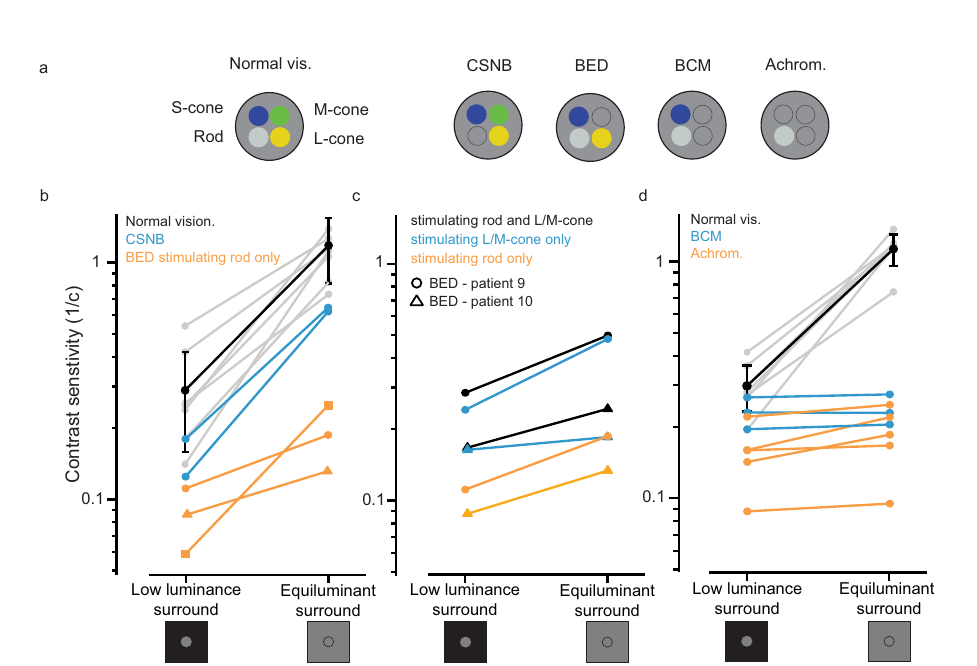
Fig. 1 A lateral adaptive input improves contrast encoding in human subjects. a Schematic of the experimental procedure. A two-alternative forced- choice task was used to measure temporal and spatial contrast sensitivity thresholds. b , c Vision was improved by an equiluminant (27.7 cd/m 2 ) vs low luminance (0.15 cd/m 2 ) surround in normal vision subjects. Temporal contrast sensitivity shown in b ( n = 8 normal vision subjects; 4 Hz p = 0.0018; 7 Hz p = 0.0010; 10 Hz p = 0.0046; 14 Hz p = 0.0043; 20 Hz p = 0.0009; 28 Hz p = 0.055; one-way ANOVA, with Tukey post hoc multiple comparison test) and acuity in panel c ( n = 6 normal vision subjects; p = 0.0004; two-sided paired t -test). d Surround luminance values (blue arrows) shift contrast encoding functions (corresponding blue color) along the x-axis, but maximum contrast sensitivity remains comparable ( n = 4 subjects). e An input gain computation (see Methods) captures the shift between luminance conditions better (top graph, r 2 = 0.94) than a response gain computation (bottom graph, r 2 = 0.53). f Schematic demonstrating the effect of two types of lateral inhibition on reduced contrast sensitivity (dashed line). Response suppression would further reduce contrast sensitivity (red); input gain can enhance contrast sensitivity (blue). g An arti fi cial scotoma (see Methods) signi fi cantly worsened contrast sensitivity thresholds measured with equiluminant surrounds ( n = 6 normal vision subjects, data normalized to values with low luminance surround). h Measurements in patients with Stargardt disease reveal a similar effect to an arti fi cial scotoma (cfr. Fig. 1g, n = 6 patients; data normalized to values with low luminance surround). i Functional mapping of the degenerating area in patients with Stargardt disease by microperimetry. Color-coded scores (in dB) are superimposed on a fundus re fl ectance image. Cyan pixels indicate fi xation measurements. Sensitivity scores guided the placement of stimuli at the edge of the functional scotoma (indicated by circular markers). j Fundus auto fl uorescence imaging (486 nm) of the retina presented in panel h , showing the extent of the macular lesion. Filled circles indicate the contrast sensitivity measurement locations. All contrast sensitivity values are calculated as 1/contrast threshold (1/c). Error bars denote standard deviations around mean values. See Supplementary Table 1 for all calculated p values. Source data are provided as a Source Data fi le.